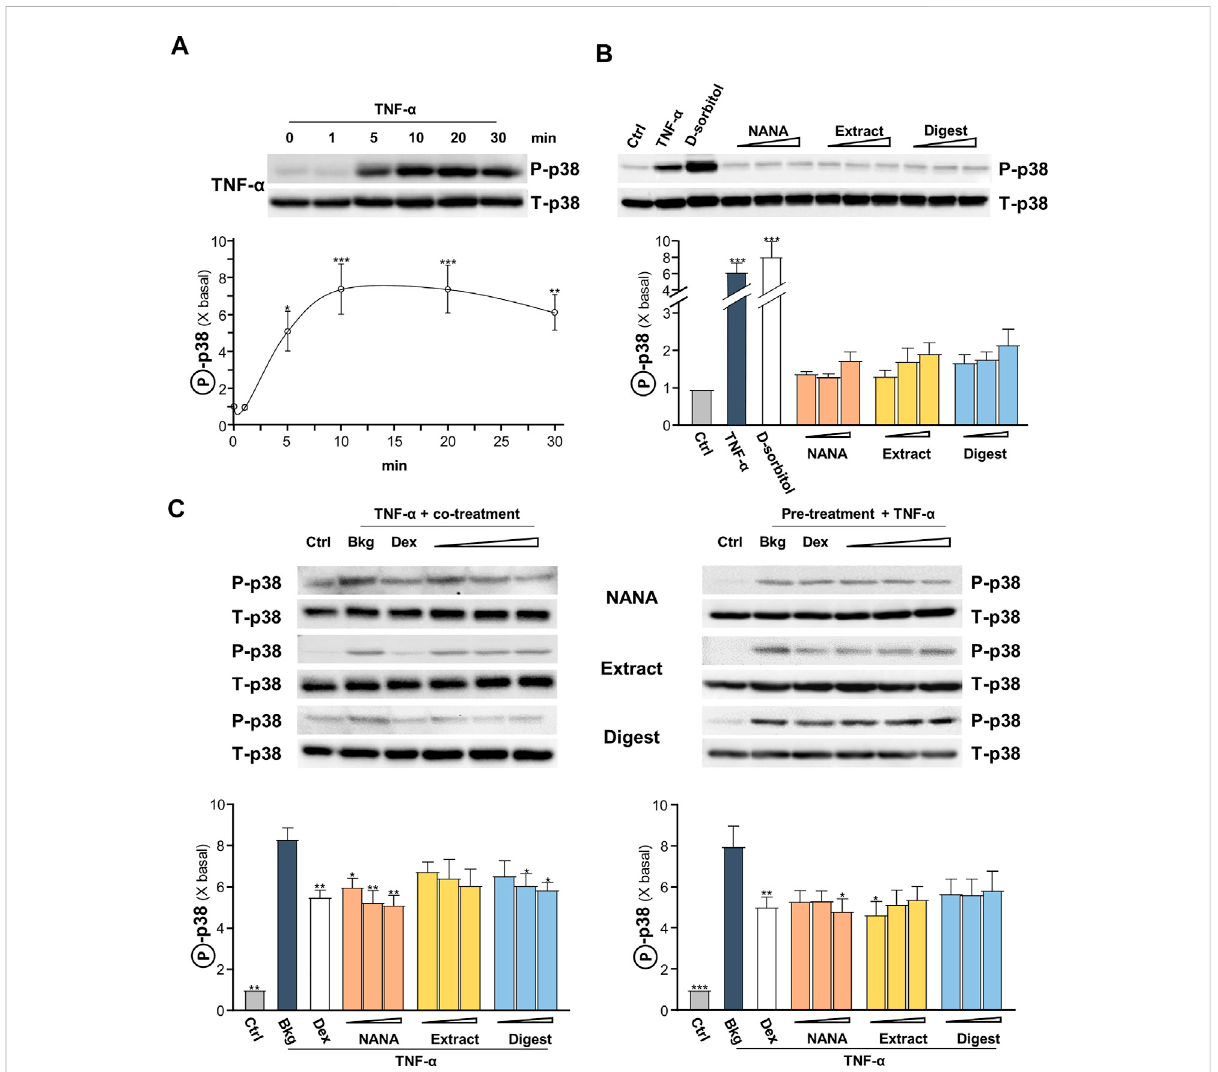
FIGURE 5 EBN inhibits TNF- α -induced p38-MAPK phosphorylation. After 16-h serum starvation, cultured keratinocytes were: (A) induced by TNF- α (20 ng/mL) ata period of 0 – 30 min,as indicated;or (B) treated with EBN preparation alone for 1-h, TNF- α (20 ng/mL), D-sorbitol (a positive control, 400 mM), NANA (0.05, 0.1, 1 mM), EBN extract and digest (both at 1, 10, 100 μ g/mL) are indicated. (C) After 16-h serum starvation, (left panel) simultaneous incubation of TNF- α together with EBN preparationfor 5 min was performed; (right panel)1-h pre-treatment of EBN preparation followed by 5 min TNF- α stimulation. The doses were as in (B) . Dexamethasone at 10 nM was a positive control. Total p38-MAPK (p38-MAPK) and phosphorylated p38-MAPK (p-p38 MAPK) (both at ~38 kDa) were evaluated by western blot assays. The values of P-p38/T-p38 under